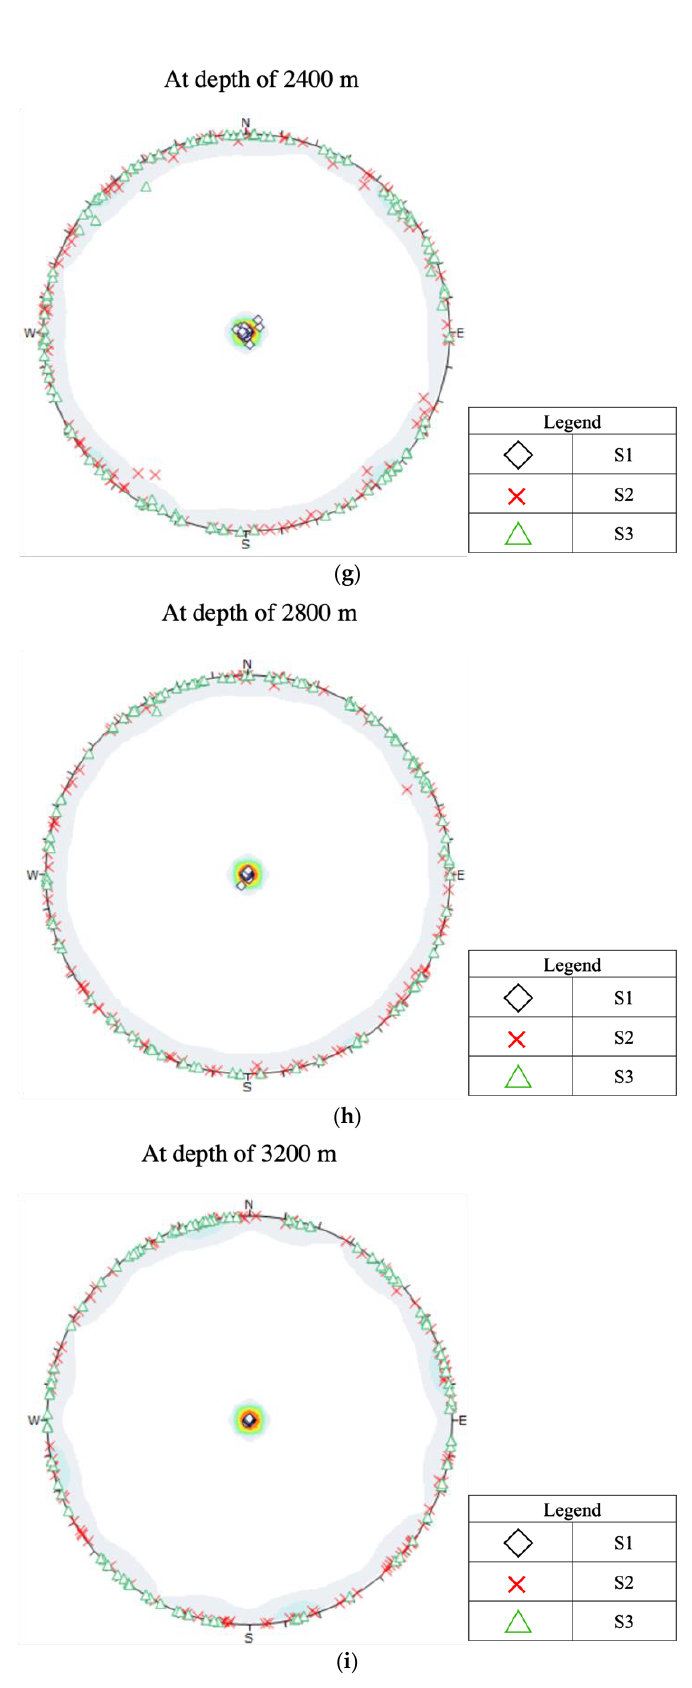
Figure 8. Stereographical projection of induced principal stress directions without tectonic stresses in the study area at depth of ( a ) 0 m; ( b ) 400 m; ( c ) 800 m; ( d ) 1200 m; ( e )1600 m; ( f ) 2000 m; ( g ) 2400 m; ( h ) 2800 m; ( i ) 3200 m.